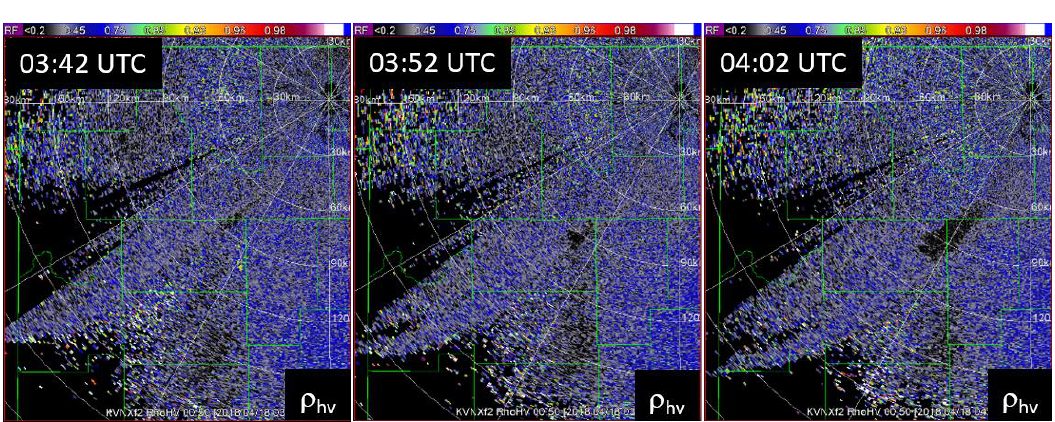
Figure 9. Fields of the correlation coefficient at the same times as in Figure 7. The elevation angle is 0.5°. Vertical cross section (RHI) of Z (Figure 10) exhibits clear separation of the ascending (pyro updraft) region ( Z > 33 dBZ) from the advected plume where ash slowly descends. However, in the vertical cross section of the ρ hv field the two regions are indistinguishable. This is unlike the findings in a Florida wildfire [32] where the ρ hv near the updraft is as low as 0.2 and increases downstream. Atmosphere 2019 , 10 , x FOR PEER REVIEW